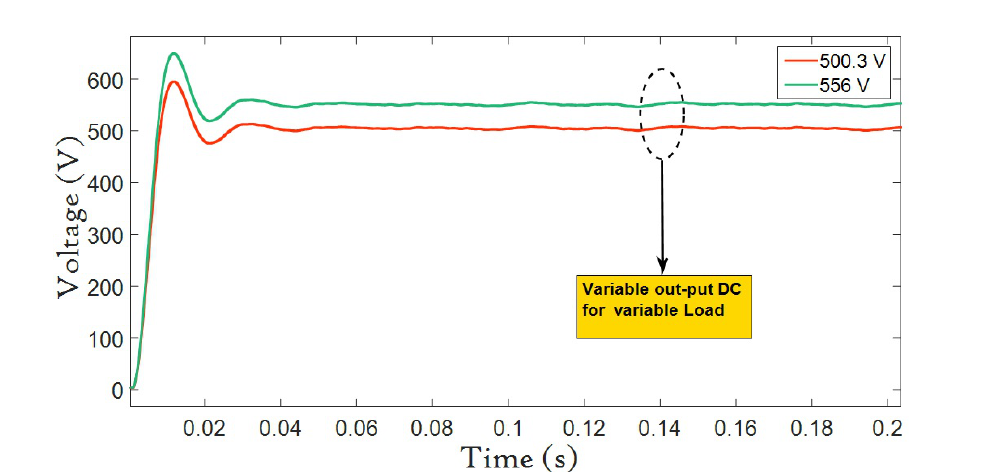
Figure 13. Port (II) 500 V variable output, which changes according to load variation.